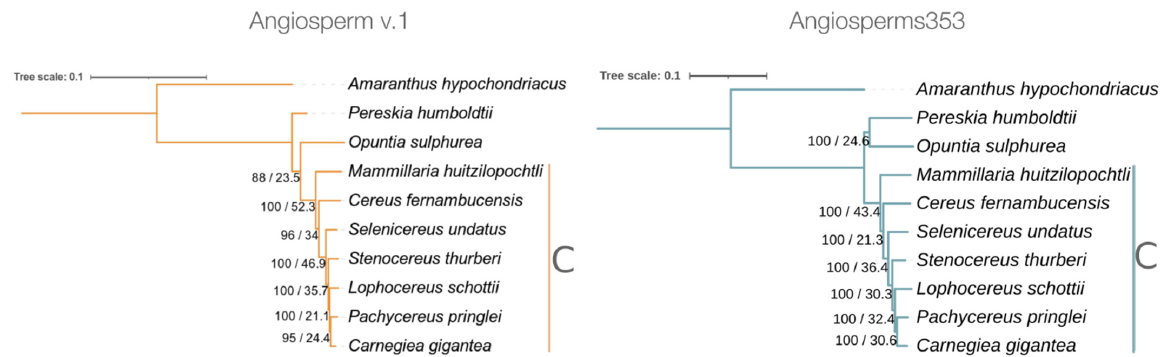
Figure 3. Phylogenetic trees obtained with ML for the nine studied cacti species; the prince’s feather ( A. hypochondriacus ) was the outgroup. The tree constructed with data from Angiosperm v.1 was based on 71 loci (20,082 bp), and that constructed with data obtained from Angiosperms353 was based on 262 loci (186,973 bp). The numbers to the side of the branches correspond to UFBoot (above slash) and gCF (below slash) values. The species grouped in the subfamily Cactoideae are indicated by the letter C.